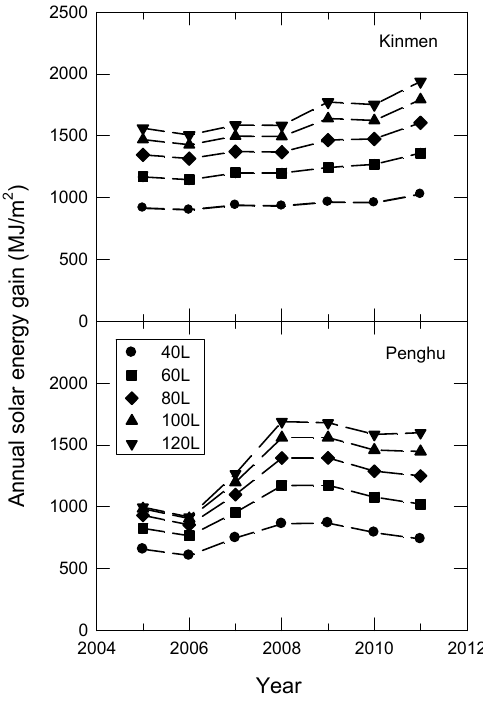
Figure 3. Effective annual solar energy gain.